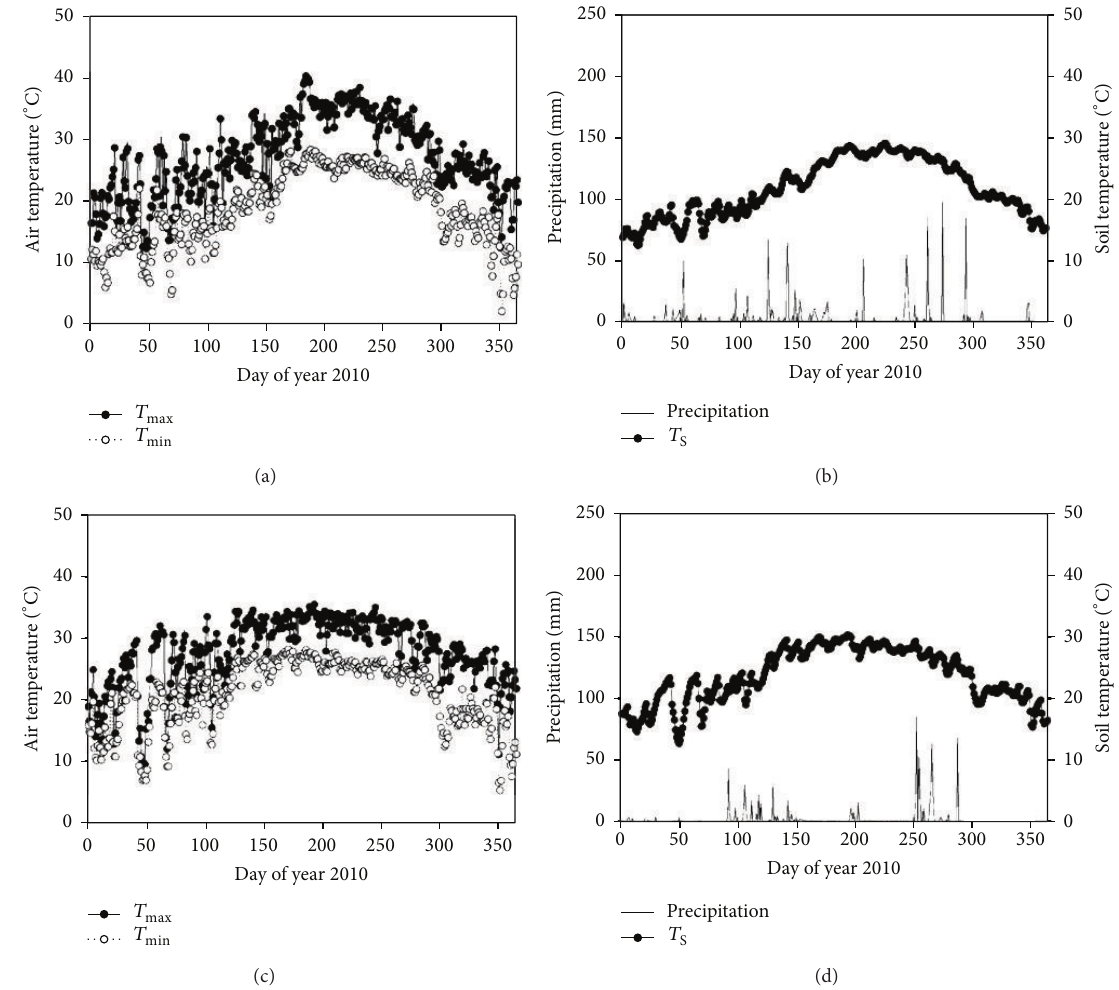
Figure 2: Seasonal variations of major meteorological variables in 2010 for FJZZ and